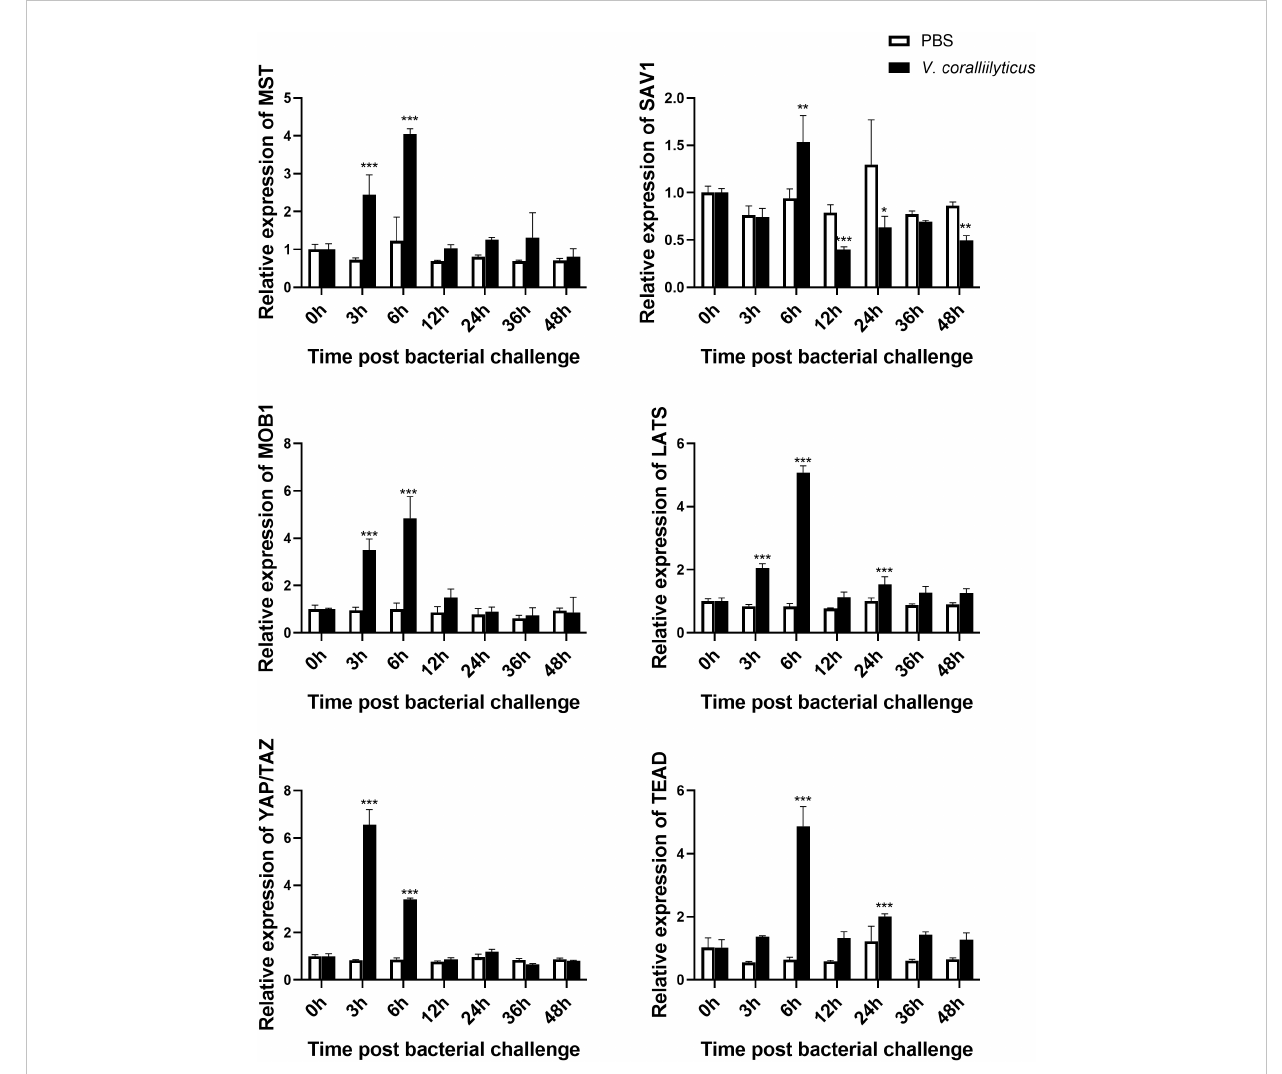
FIGURE 4 Expression pro fi le of the Hippo pathway in C. hongkongensis post-challenge. The mRNA expression of core components of the Hippo pathway upon V. coralliilyticus challenge were examined by qRT-PCR. Data analysis was performed by using GraphPad Prism 9 software, and vertical bars represent mean ± SD ( n = 3). *** p < 0.001; **p < 0.01; *p <